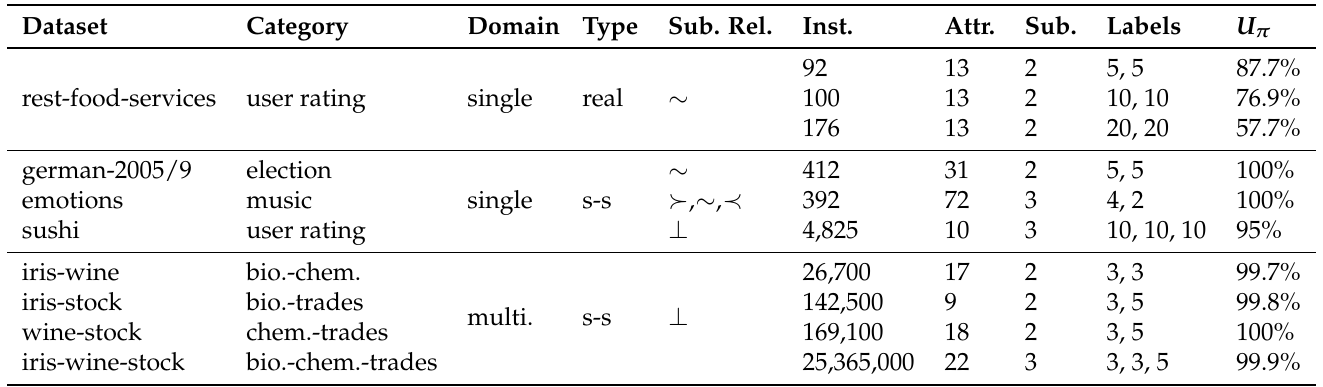
Table 2. Datasets description used for SGPNN